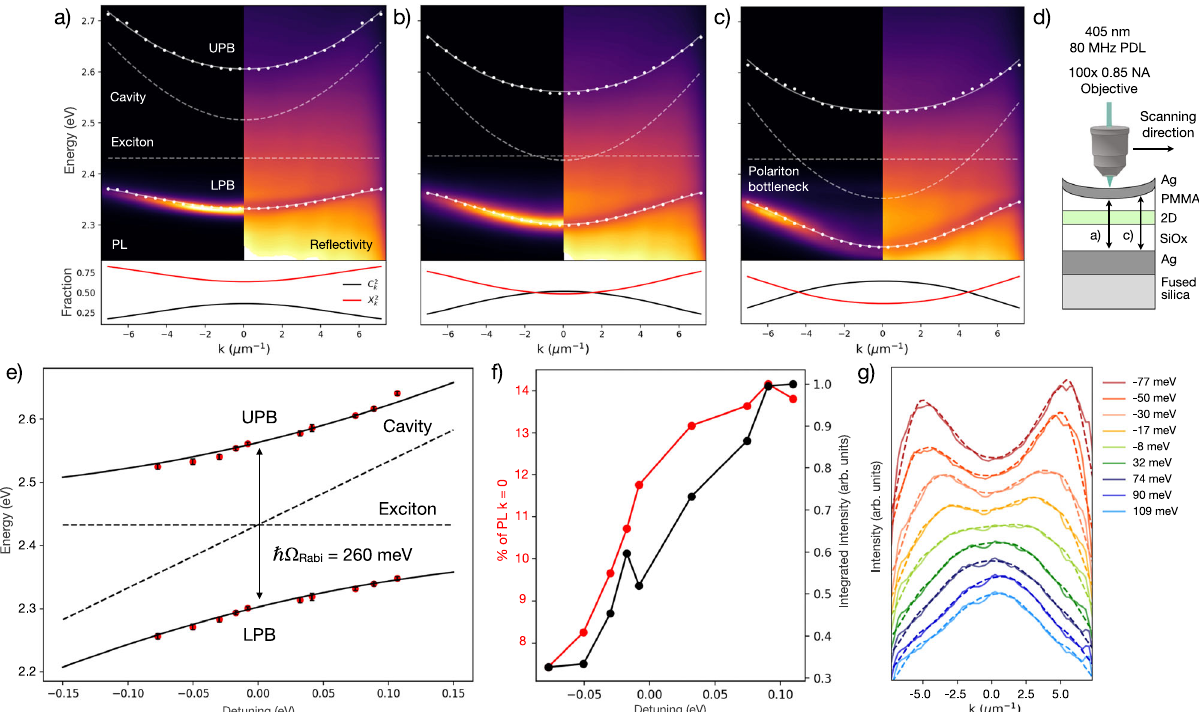
Fig. 1 | Room-temperature exciton-polariton formation. Exciton-polariton photoluminescence (PL) (left) and re fl ectivity (right) dispersions with increasing cavitylengthfrom a highercavitymodeenergyto b , c lowercavitymodeenergyas shown schematically in d . As the cavity shifts to lower energies and the polariton dispersion becomes increasingly photonic c , the bottleneck effect emerges with thegreatestemissionintensityathigh k || values.UPBandLPBenergiesareextracted from re fl ectivity minima (white dotted line) and fi tted (white solid line) using Eq. 1 ( fi ttedcavityandexcitonenergiesshown,whitedashedline)withaRabisplittingof _ Ω – c , lower fi gures) Hop fi eld coef fi cients for cavity detunings Rabi = 260meV. ( a (photonic fraction C k 2 , black trace; excitonic fraction X k 2 , red trace) ranging from a excitonicto c photonicdepictingthelight-mattercharacteristicsofthegenerated